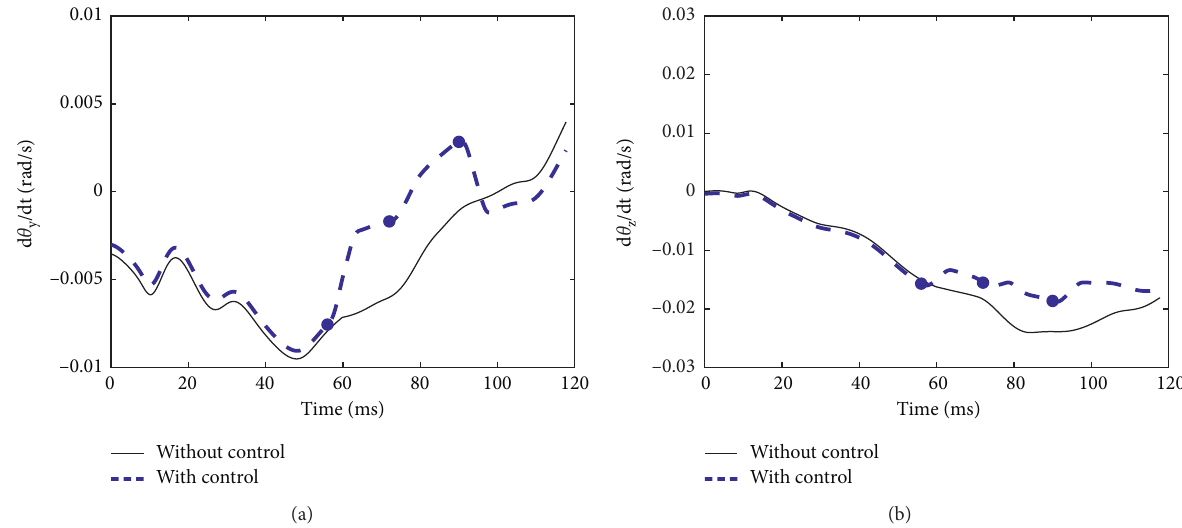
Figure 8: Simulated results of the elevation part in launching process for the 6th rocket under Condition 1: (a) the yawing angular velocity and (b) the pitching angular velocity. The blue dots indicate the action of the AAT.